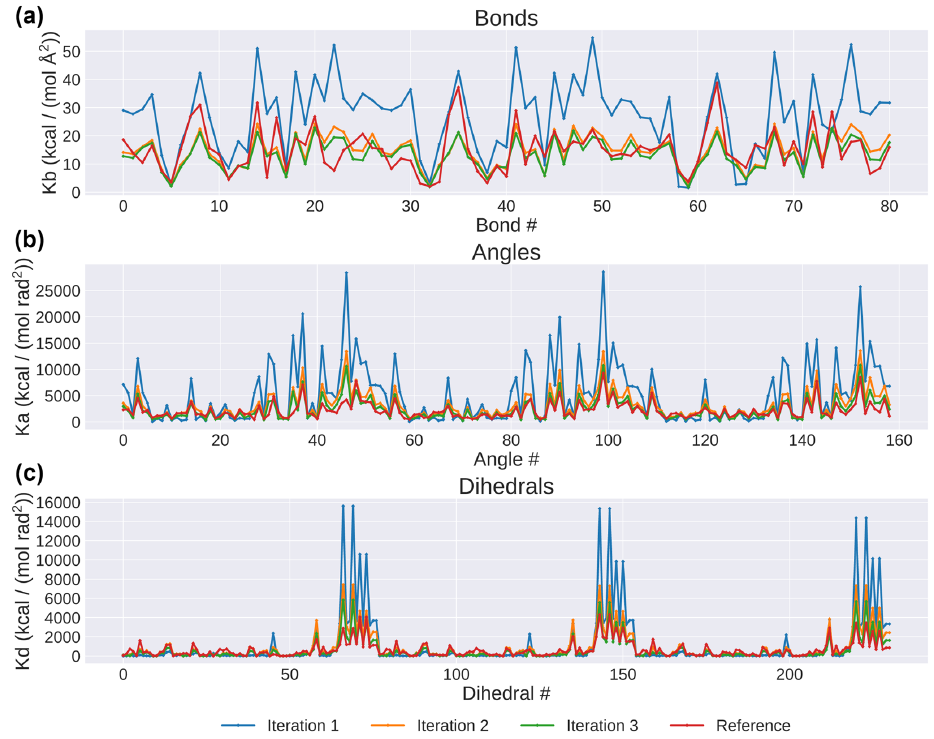
Figure A2. Illustration of IBI method’s initialization of parameters for 3 iterations. Bonds ( a ); angles ( b ); dihedrals ( c ).